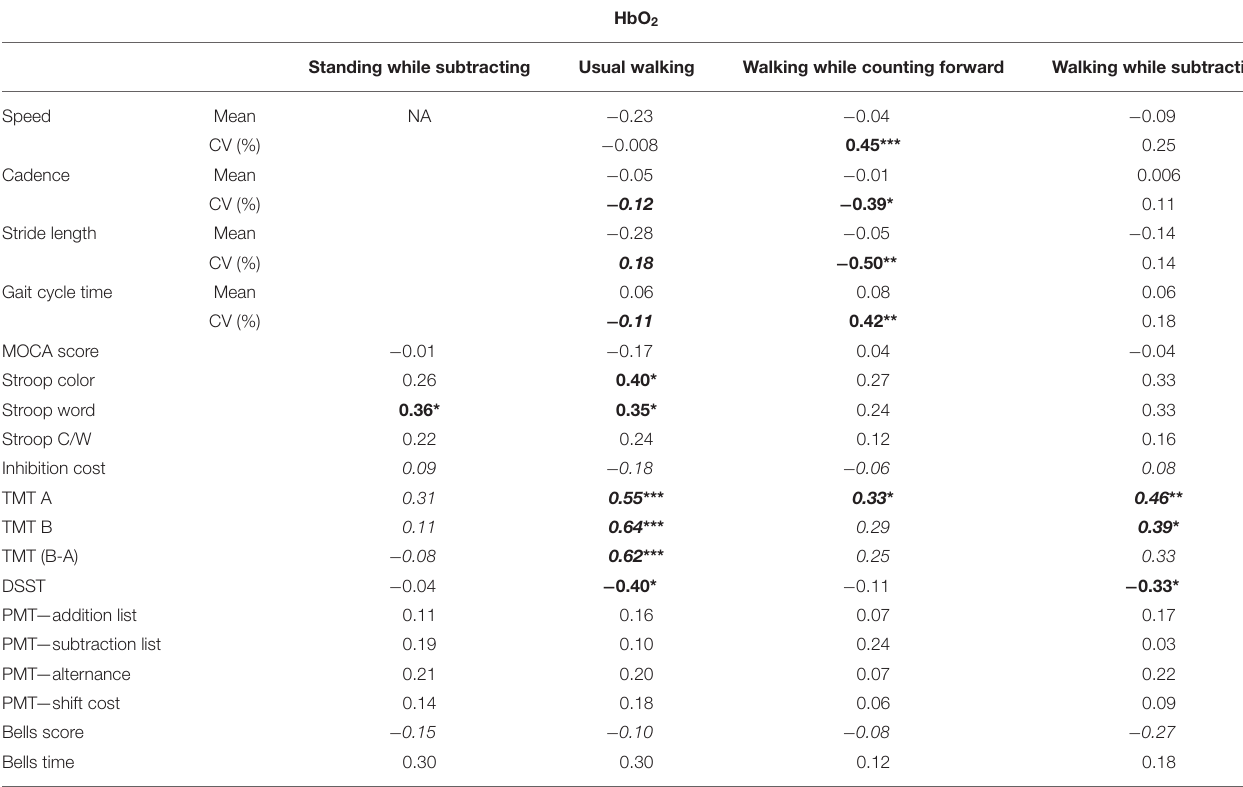
The values correspond to Pearson correlations except for the ones in italics which represent Spearman correlations. Values in bold are significant. * p < 0.05; ** p < 0.01; *** p < 0.001. DSST, Digit Symbol Substitution Test; NA, Not Applicable; PMT, Plus-Minus Task; TMT, Trail Making Test.